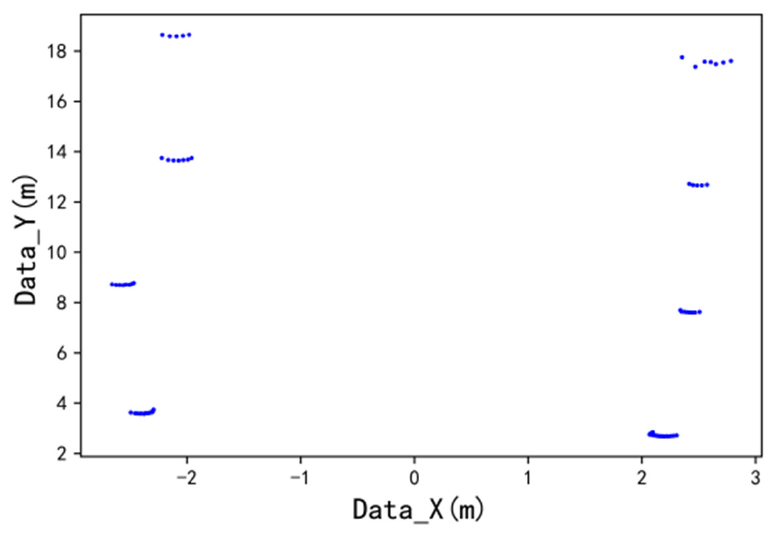
Figure 4. Simulation data.